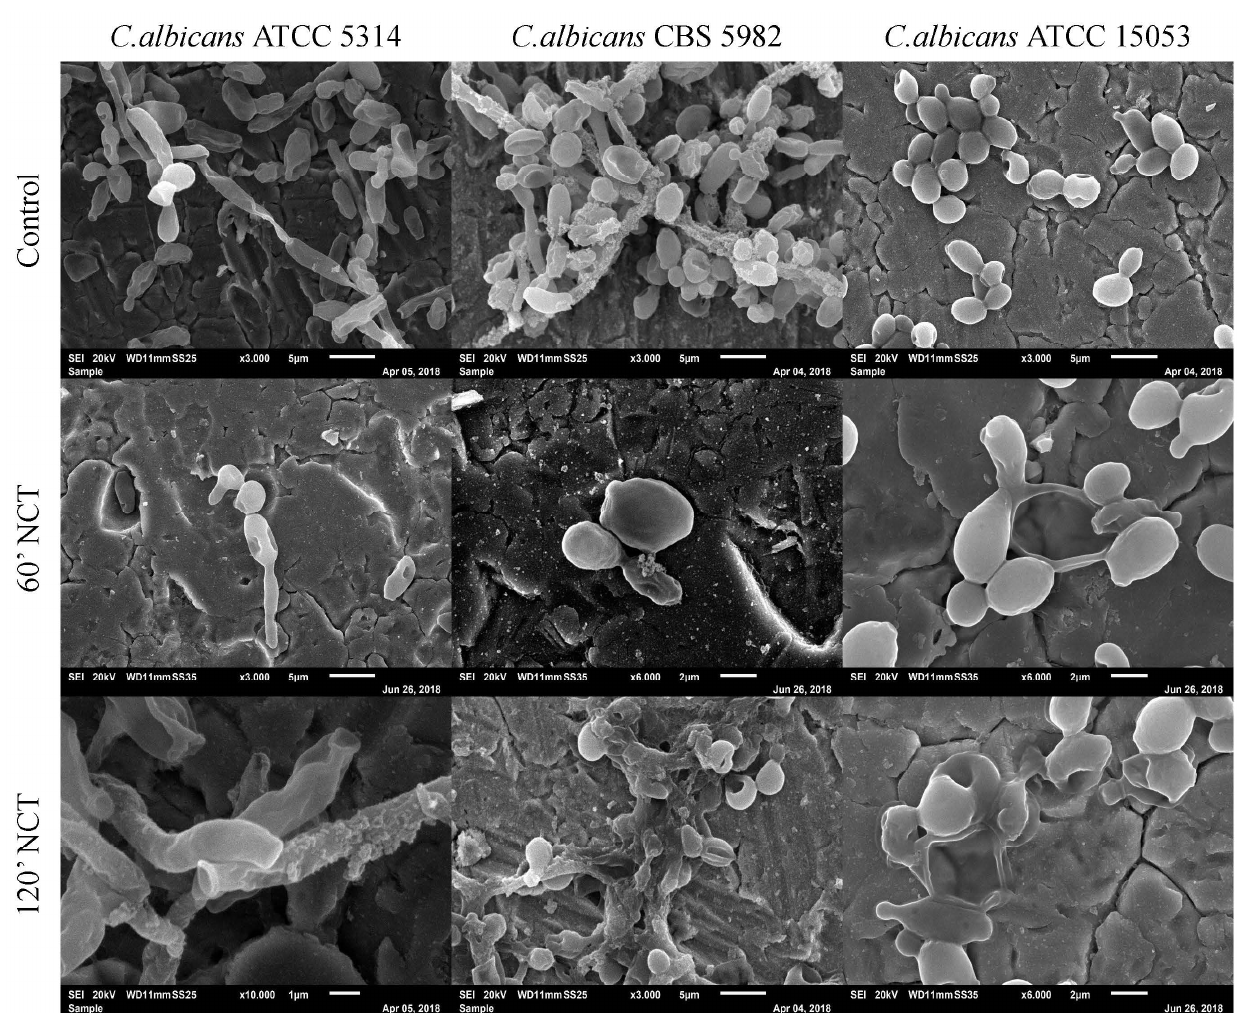
Figure 10. Scanning electron microscopy of 3-week-old C. albicans ATCC 5314, C. albicans CBS 5982 and C. albicans ATCC 15053 biofilms. Upper row : mock-treated control biofilms (Magnification: 3000×); middle row : biofilms treated with NCT, for 60 min (Magnification: C. albicans ATCC 5314 3000×; C. albicans CBS 5982 and C. albicans ATCC 15053 6000×); lower row : biofilms treated with NCT for 120 min (Magnification: C. albicans ATCC 5314 10,000×; C. albicans CBS 5982 3000× and C. albicans ATCC 15053 6000×). Specimens were analyzed by scanning electron microscopy (SEM, JSM-6010LV, JEOL GmbH, Freising, Germany).